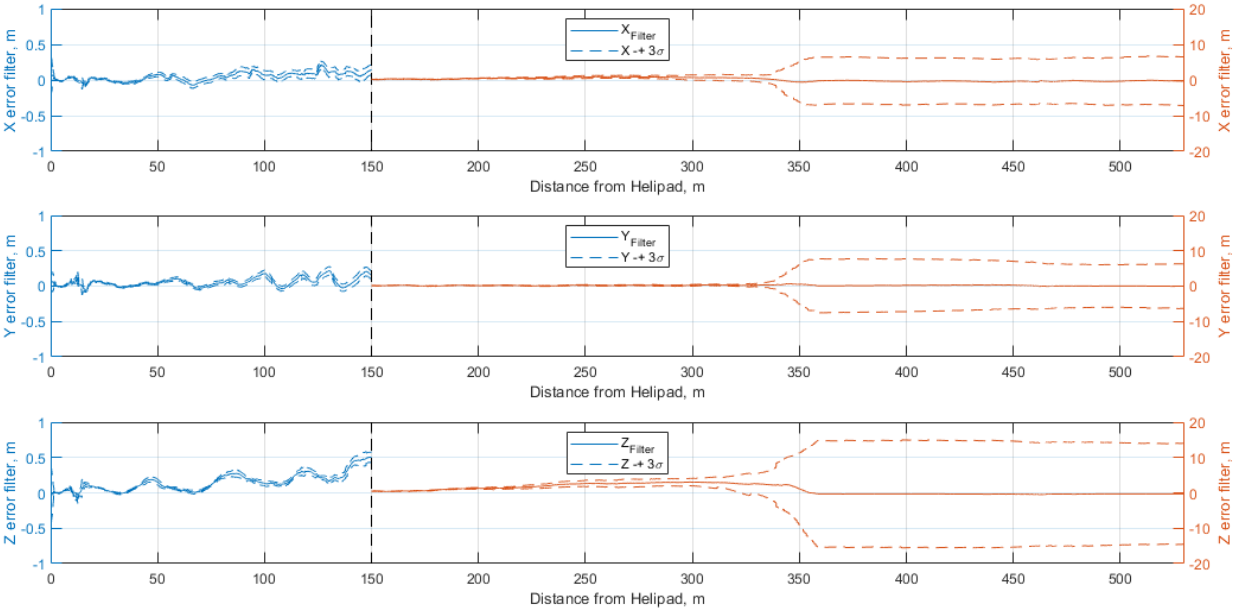
Figure 13. EKF position estimates errors average over 50 simulations and 3 − sigma bounds. VTCA landing trajectory in nominal visibility conditions with disturbances applied to the path. The plot scale is increased in the last 150 m to better show the errors in the final phase of the approach.